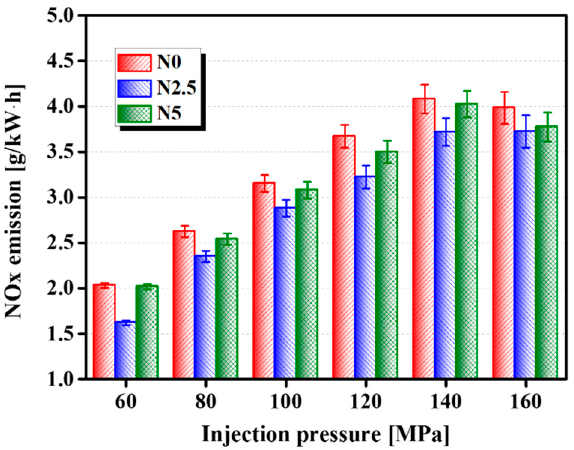
Figure 11. NO X emissions of different injection pressures for n -octanol/diesel blends .